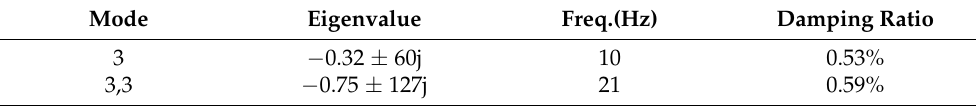
Figure 19. Mechanism explanation of instantaneous oscillation frequency changing with time. Table 2. Prony analysis results of nonlinear oscillation response.